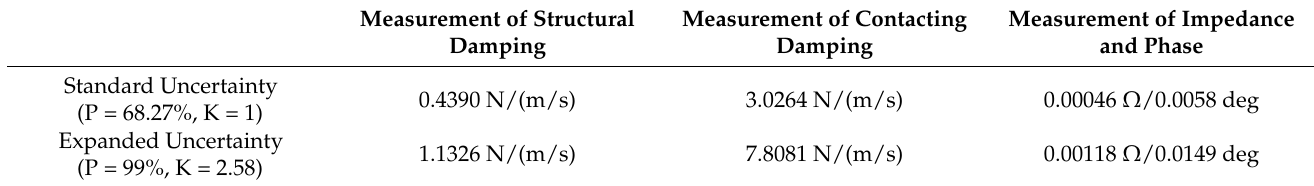
Table 4. Estimated uncertainty of measurements.